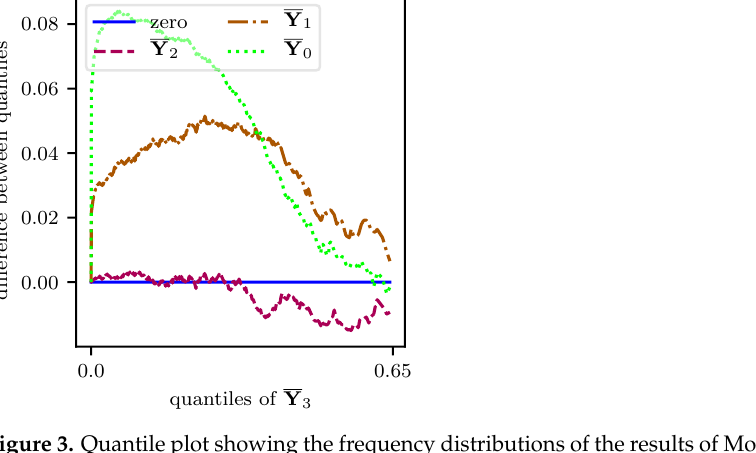
Figure 3. Quantile plot showing the frequency distributions of the results of Monte-Carlo simulations for the RSMs Y 0 , Y 1 , Y 2 , Y 3 of all refinement steps relative to the RSM Y 3 . The Monte-Carlo simulations combines both random scenarios with TA and